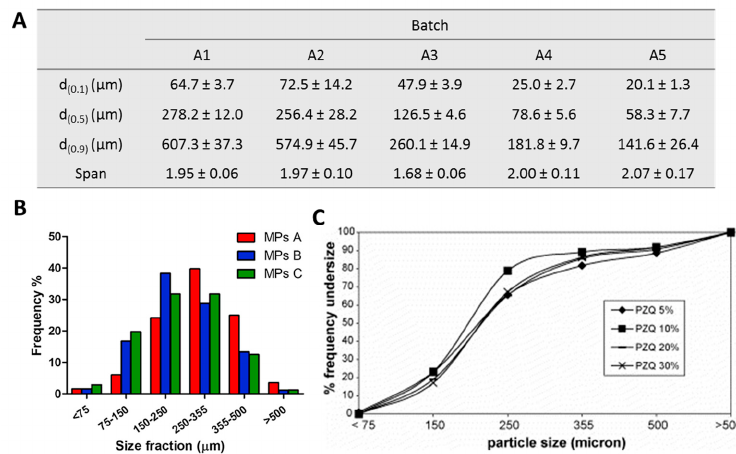
Figure 5. Particle size distributions of spray congealed microparticles (MPs) based on Gelucire ® 50/13. ( A ) Effect of different atomizing air pressure (increasing pressure values passing from A1 to A5); ( B ) composed of Gelucire ® 50/13 and Gelucire ® 48/16 in ratios of 100:0 (MPs A), 50:50 (MPs B), and 30:70 (MPs C) and loaded with 10% w/w of indomethacin; ( C ) containing different amount of drug praziquantel (PZQ). Figures adapted with permission from [19,36,45].